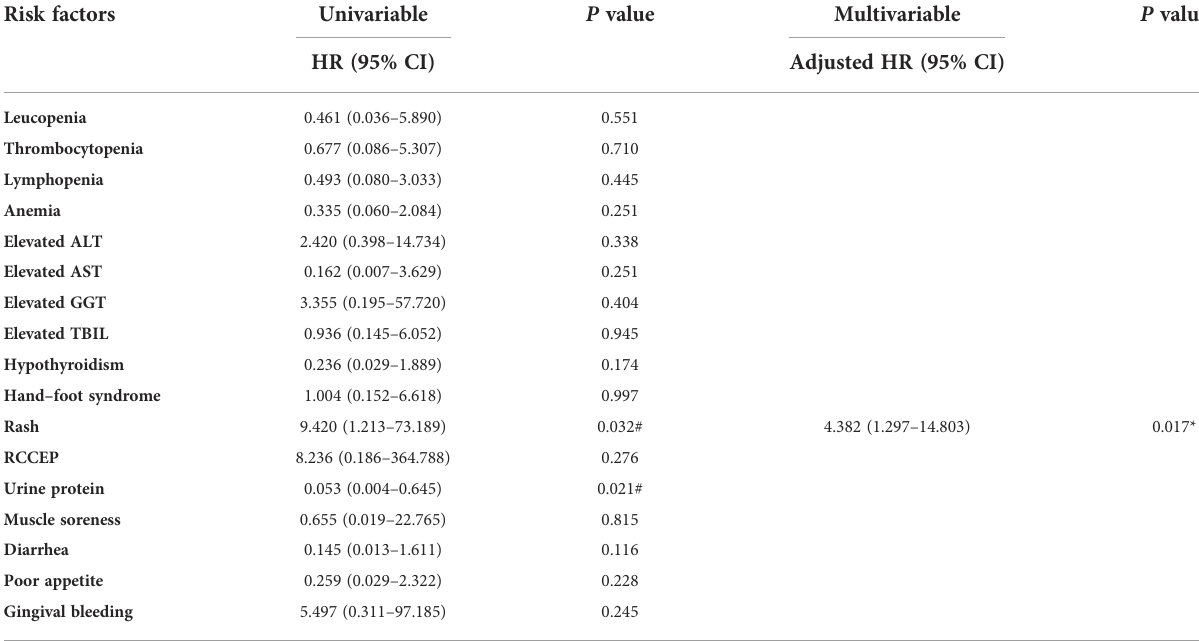
TABLE 7 Logistic analysis of adverse events for ORR during treatment in all